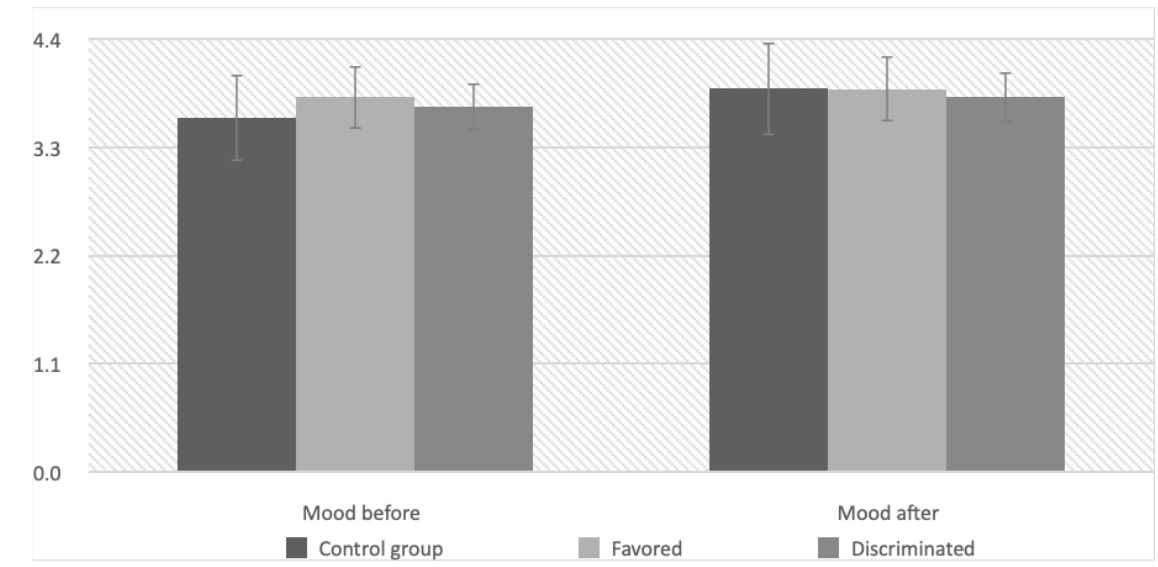
Figure 3. Means with 95% confidence interval for the mood variables in the control group, in the favored participants, and in the discriminated. Table 3. Differences in the robot’s likeability and participant’s assessment of the robot. Control Group